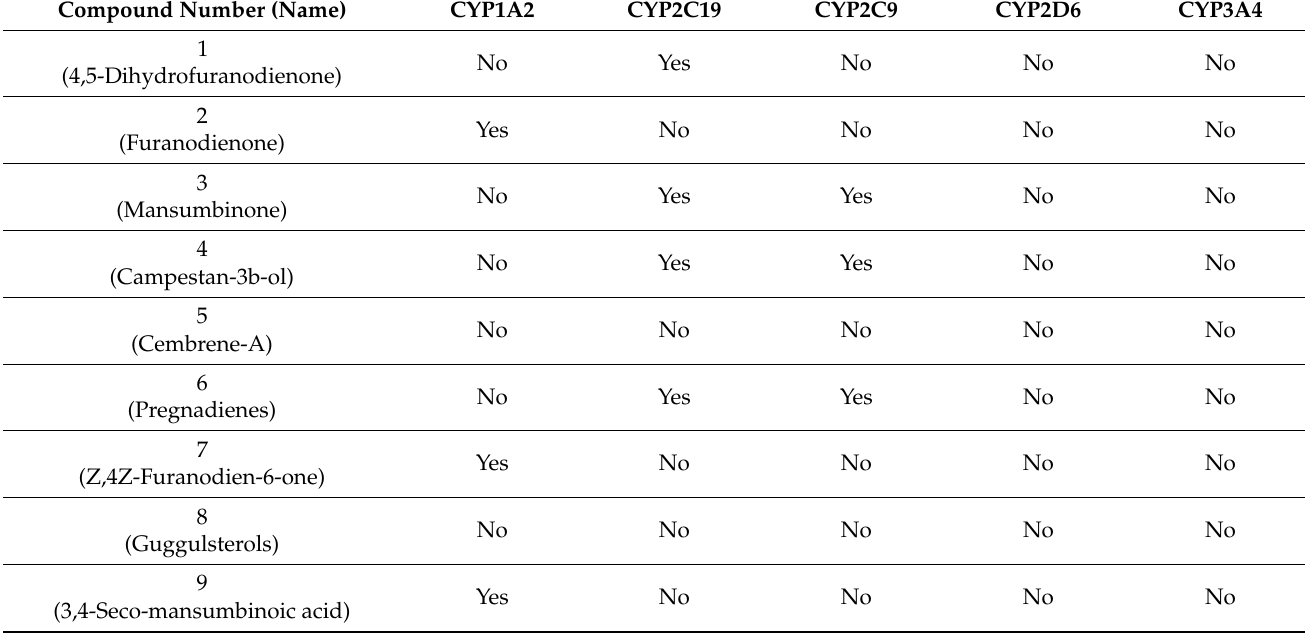
Table 7. CYP enzyme inhibition profile for crude myrrh resin using SWISSADME